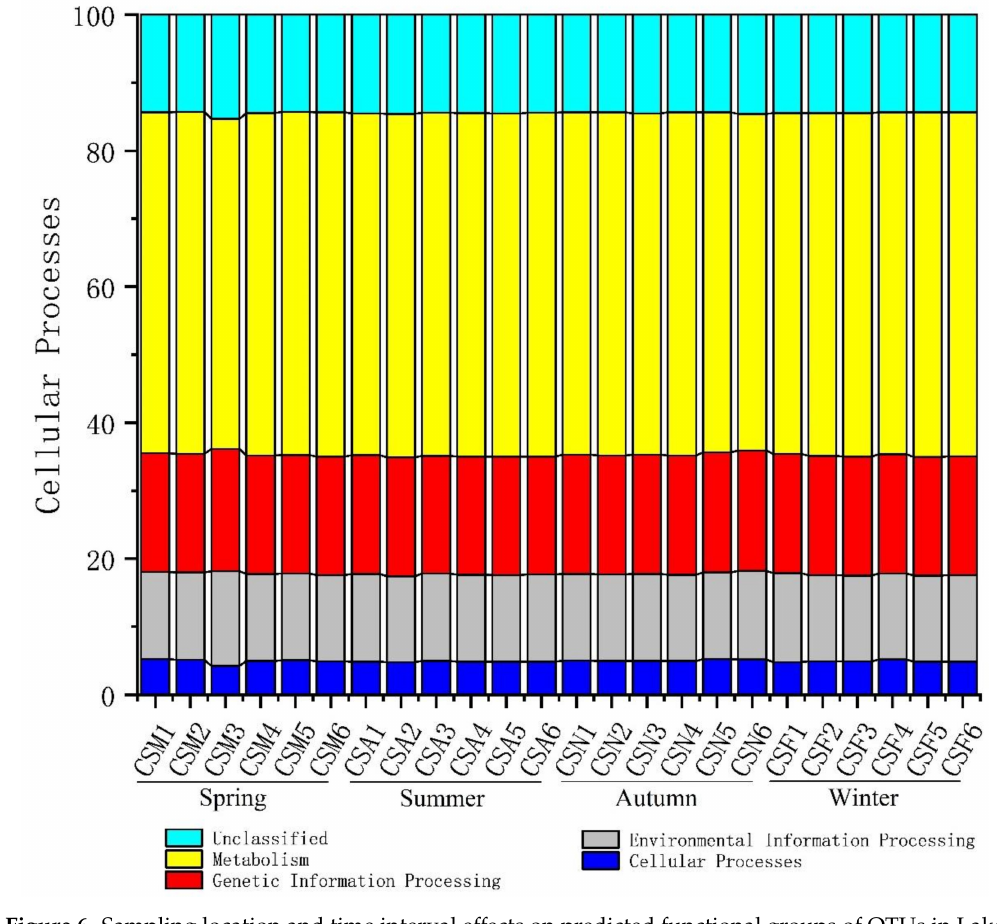
Figure 6. Sampling location and time interval e ff ects on predicted functional groups of OTUs in Lake Chaohu sediment bacteria based on the KEGG (Kyoto Encyclopedia of Genes and Genomes) database. Functional groups with less than 1% relative abundance are not